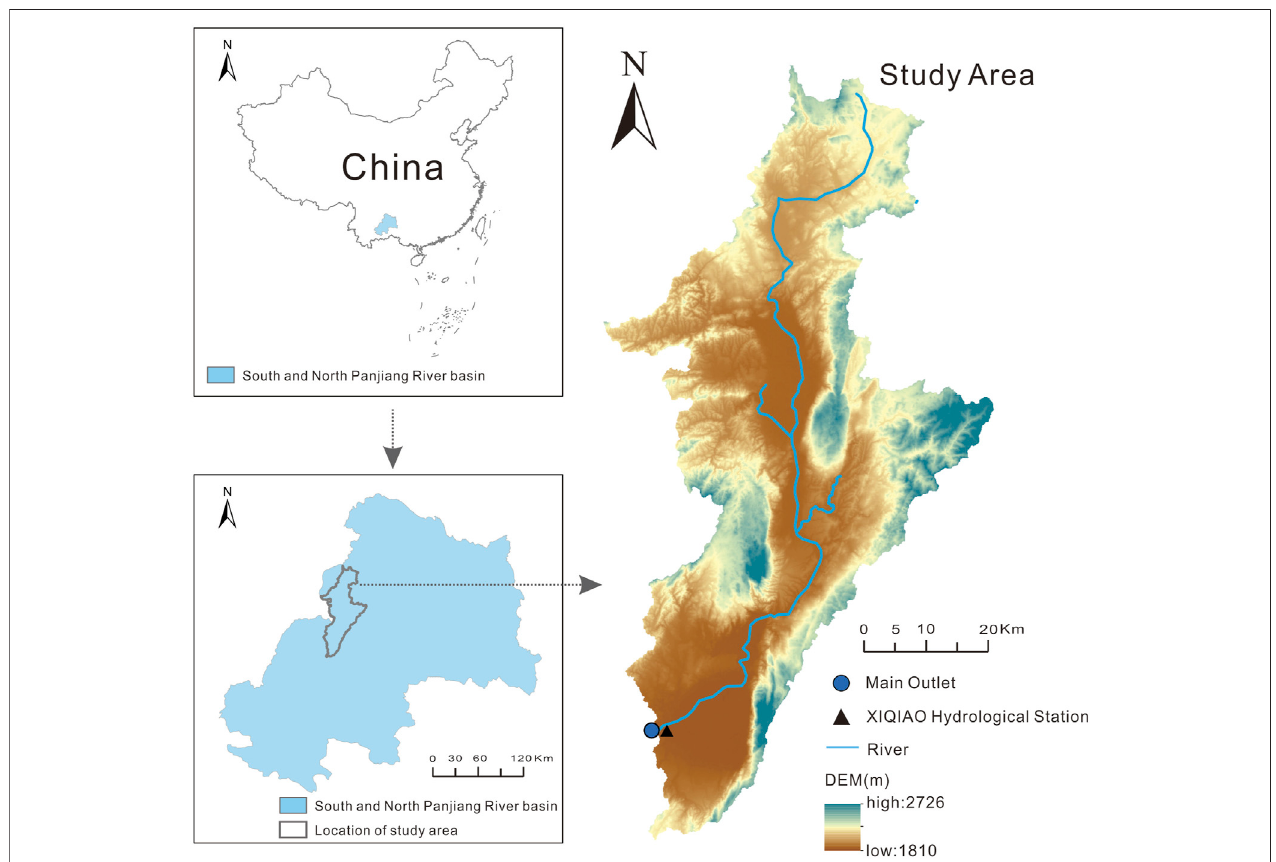
FIGURE 1 | Location of the study